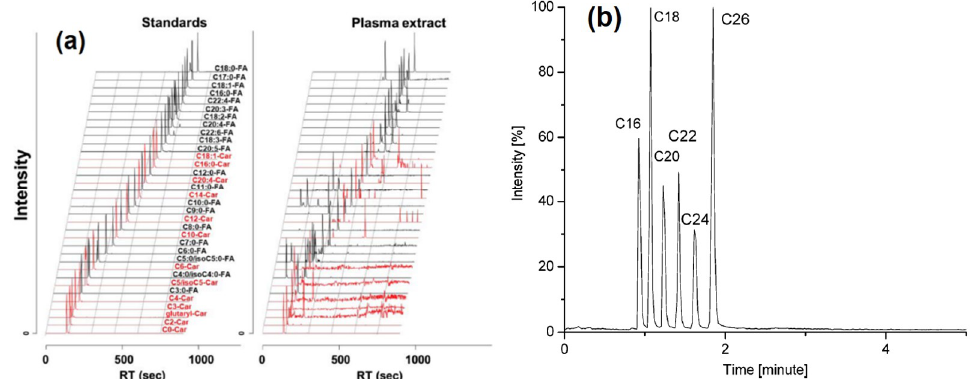
Figure 4. ( a ) LC-MS/MS chromatogram of derivatized fatty acids and acylcarnitines in the standards sample and plasma extract. [23]—Reproduced with the permission of Springer Nature; ( b ) LC-MS chromatogram of six non-derivatized fatty acids. [26]—Copyright (2004) American Chemical Society.